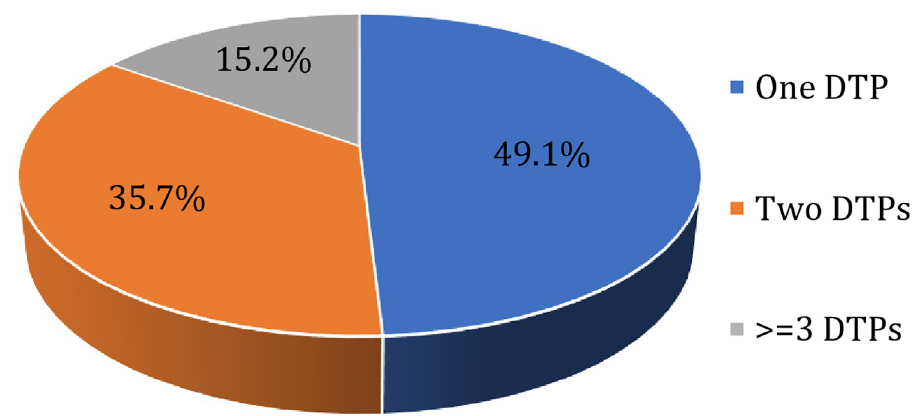
Fig 1. Number of drug therapy problems among epileptic patients attending the ambulatory clinic of JMC, 2021.